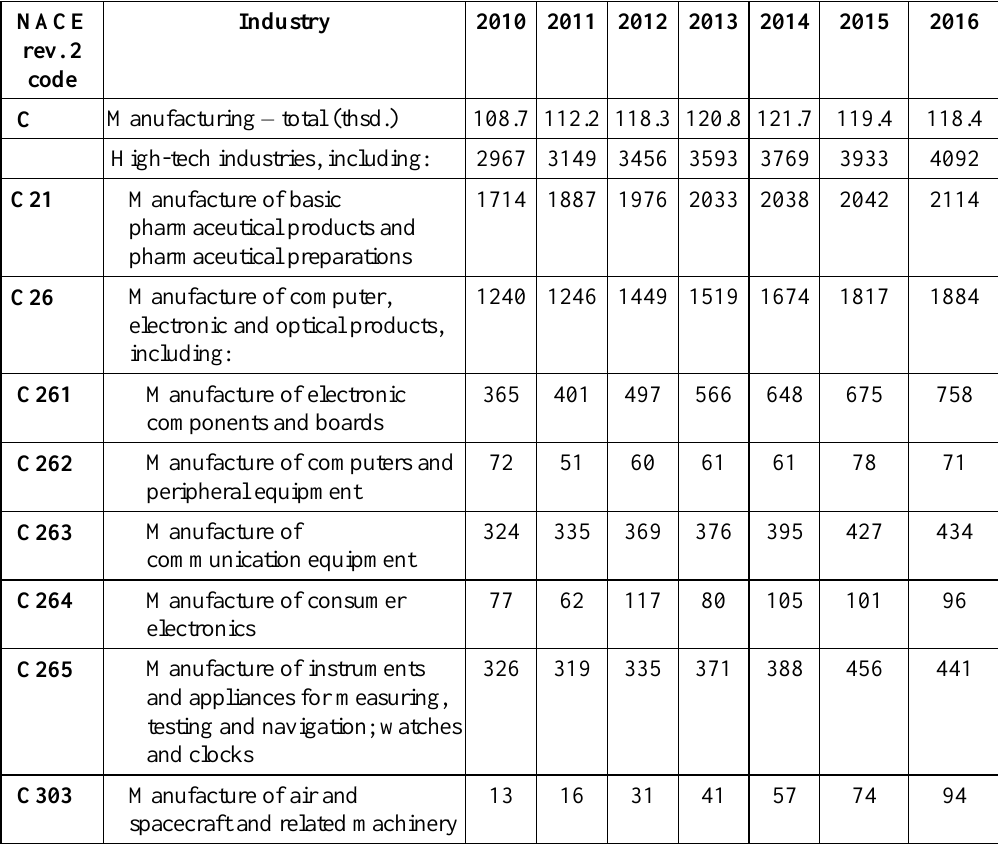
Table 2. Number and Dynamics of Employees in High-Tech Industries in